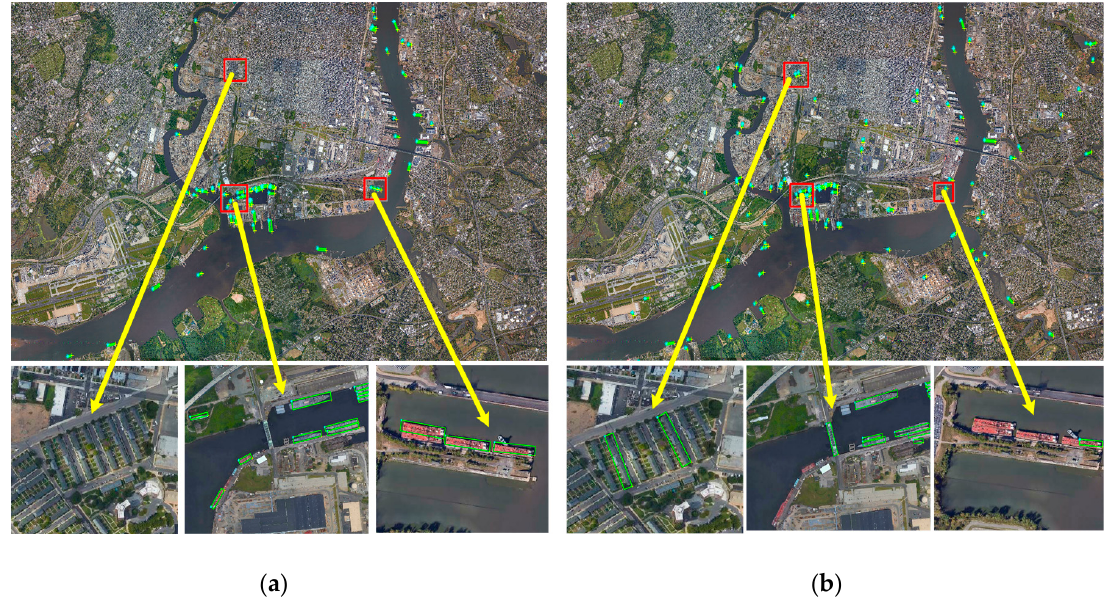
Figure 9. The comparisons of our detection results with different combination strategies.( a ) Our proposed method, ( b ) SW + proposed method, ( b ) SW+DSOD.